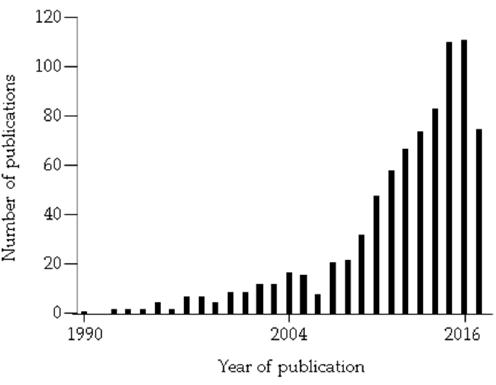
Figure 1. Number of publications on FKBP51 per year since 1990. The numbers are based on a Pubmed search that included FKBP5, FKBP51, FKBP54, FKBP 5, FKBP 51, and FKBP 54. The initial publications described FKBP51 as immunophilin p54. For 2017, citations were retrieved October 30 of this year.